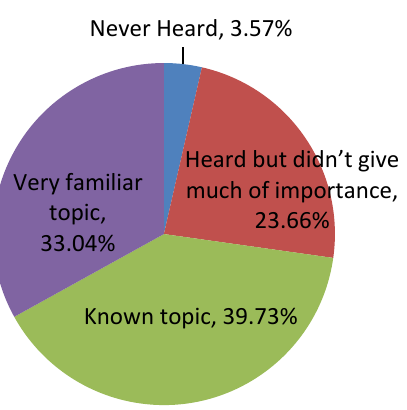
Never Heard, 3.57%